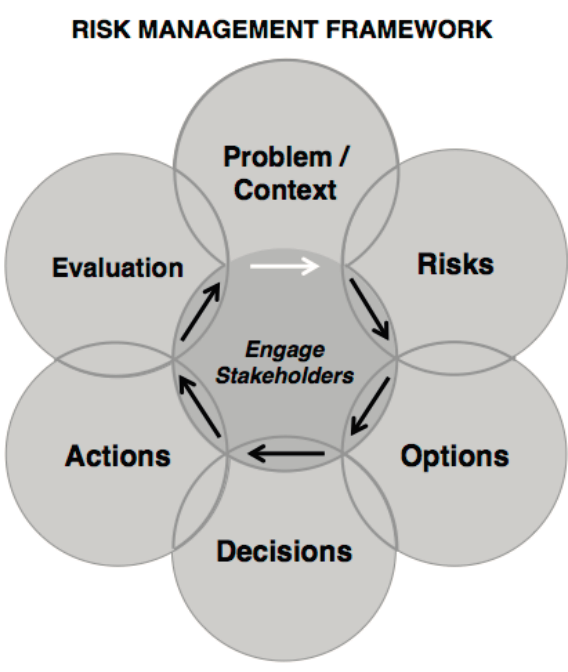
Figure 3. The six-stage “framework for risk management decision-making” (from Mendler de Suarez et al. [12], based on Omenn